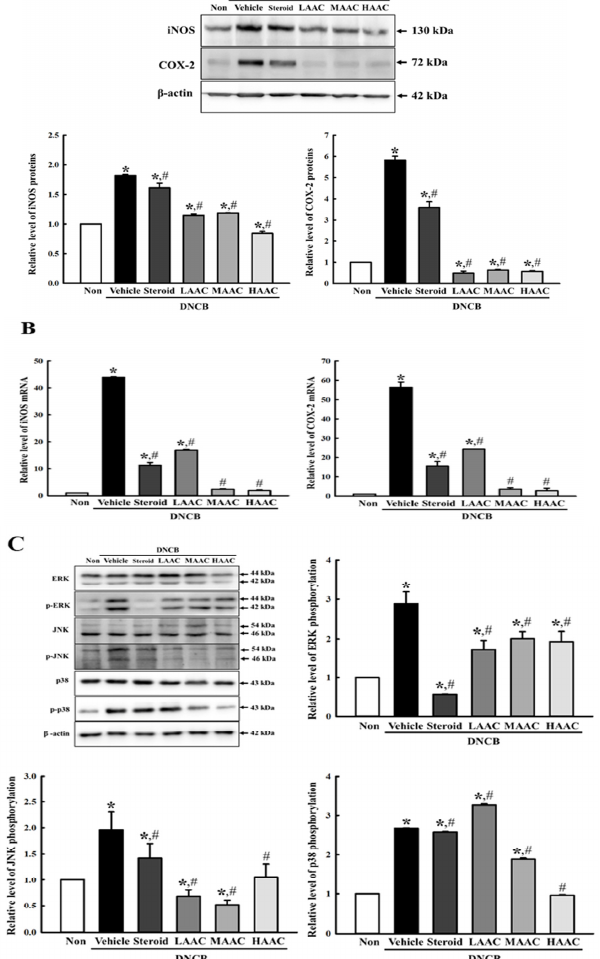
Figure 10. Regulation on NO producing system in DNCB-treated BALB/c mice spread with AAC. ( A ) iNOS and COX-2 protein expression. After the preparation of total tissue homogenate from DNCB+AAC-treated BALB/c mice, the expression levels of the two proteins were detected using Western blot. ( B ) iNOS and COX-2 mRNA transcription. The levels of iNOS and COX-2 transcripts were measured in the total mRNA of DNCB+AAC-treated BALB/c mice by RT-qPCR using specific primers. ( C ) Expression levels of key members in MAPK signaling pathway. The phosphorylation level of each protein was calculated as the ratio of phosphorylated to unphosphorylated forms. The total proteins homogenates and RNAs were prepared from four to six mice per group, and Western blot and RT-qPCR analyses for each sample were performed in duplicate. All values in the results are represented as the means ± standard deviation (SD). * indicates statically significance compared to the non-treated group, while # indicates statistical significance compared to the DNCB+Vehicle-treated group. Abbreviations: AA, abietic acid; DNCB, 2,4-dinitrochlorobenzene; LAAC, low concentration of AA cream; MAAC, medium concentration of AA cream; HAAC, high concentration of AA cream; iNOS, inducible nitric oxide synthase; COX-2, cyclooxygenase-2; ERK, extracellular signal-regulated kinase; JNK, c-Jun N-terminal